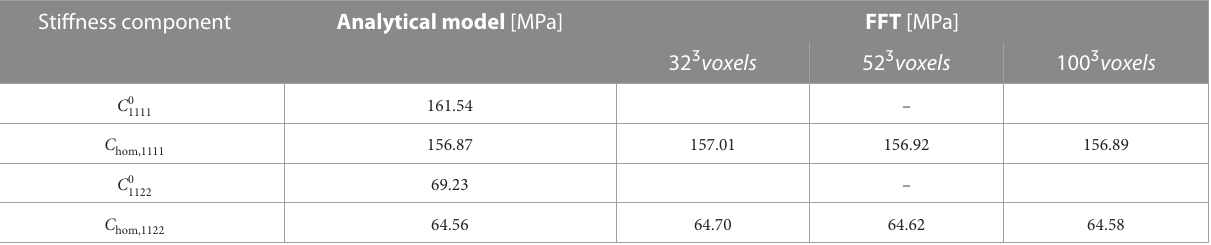
TABLE3 Numericalvalueofstiffnesstensorcomponentsofthebenchmarkexamplecalculatedbymeansoftheproposedanalyticalmodel,seeEq. 129,andby FFTwithdifferentdiscretizations. Stiffness